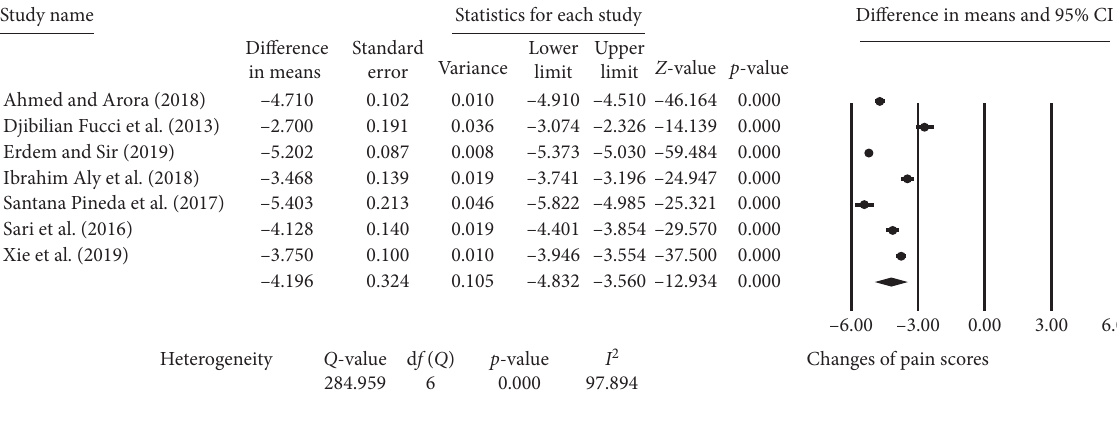
Figure 2: Summary of different biases in the randomized controlled trials (RCTs) of ultrasound-guided radiofrequency (RF) in the treatment of patients with knee osteoarthritis (KOA).